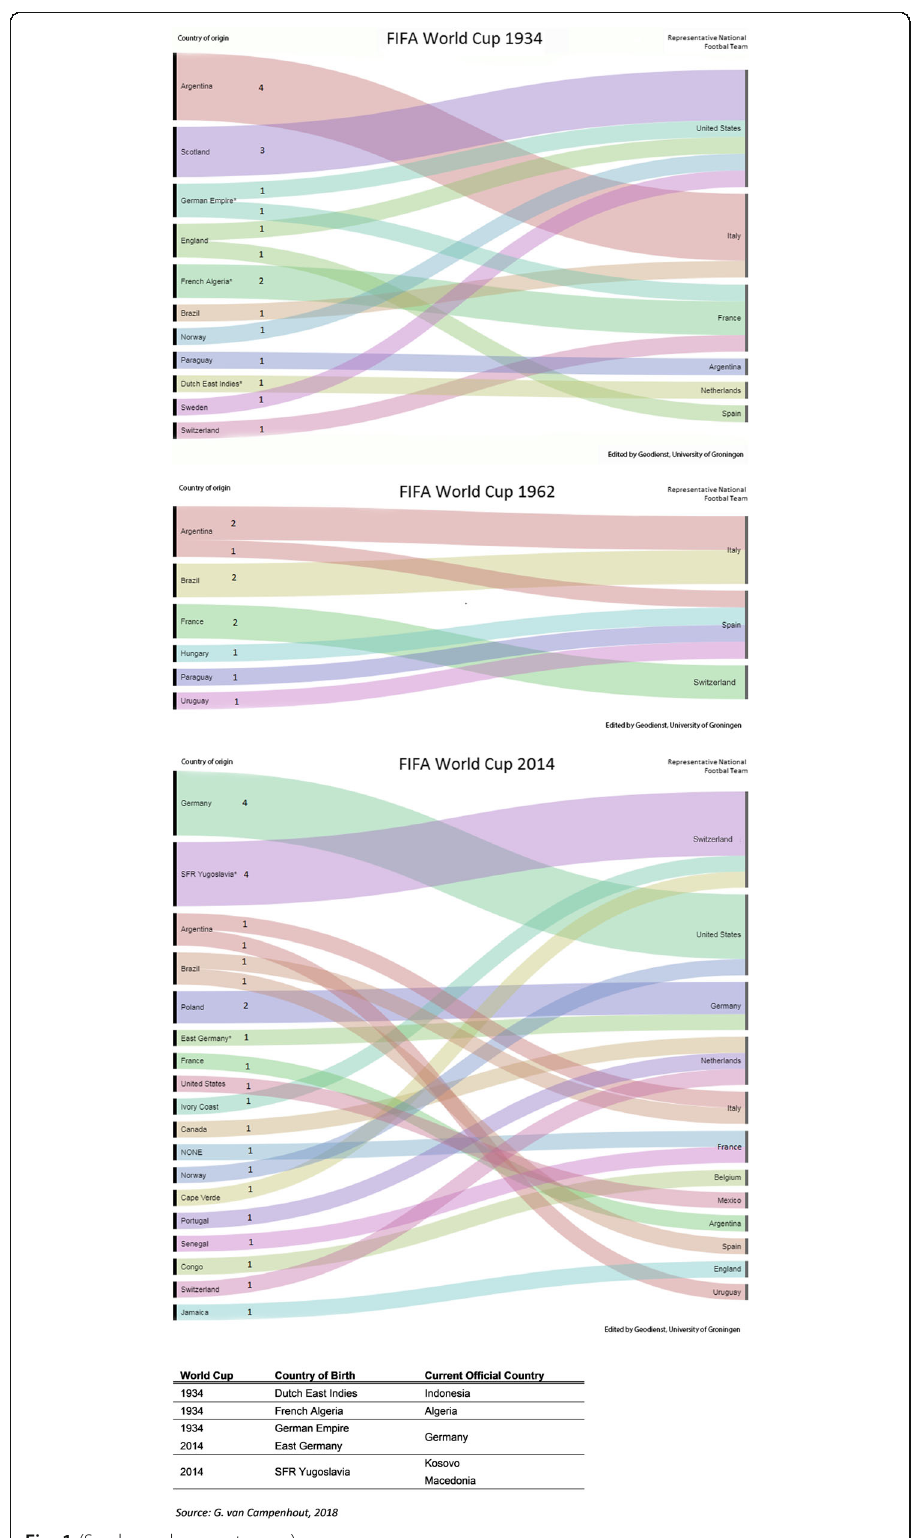
Fig. 1 (See legend on next